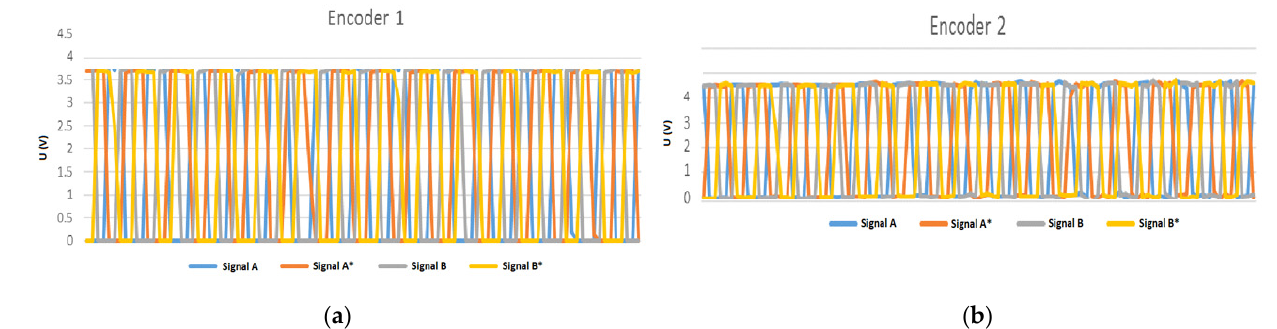
Figure 15. ( a ) A and A*, and B and B* signals for incremental encoder 1; ( b ) A and A*, and B and B* signals for incremental encoder 2.